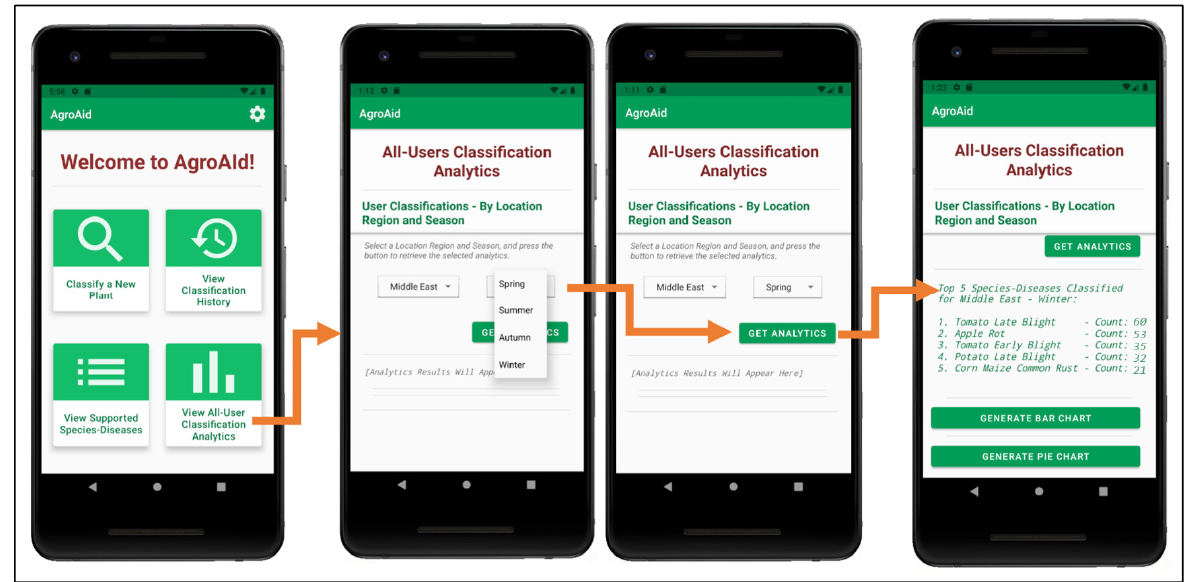
Figure 31. Example of generating user-wide spatiotemporal analytics for a selected region and season filter.